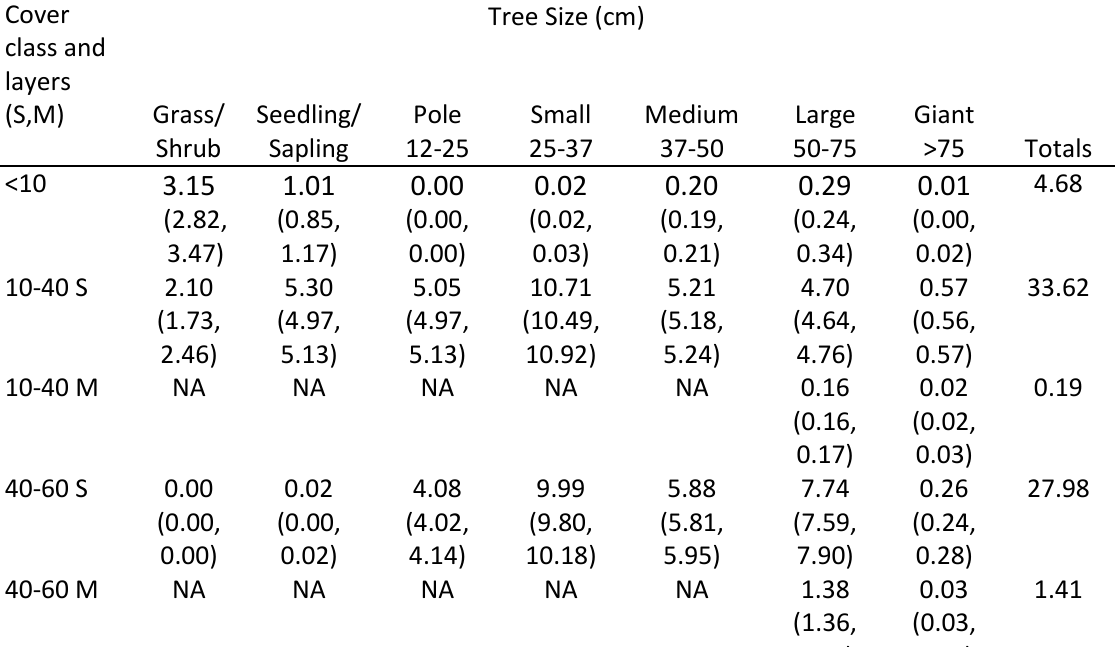
Table A1.2. Mean percent of study area in vegetation structure (cover, tree size and layers (single or multi)) used in state and transition models at year 50. Values in parentheses are lower and upper 95 th percentile confidence intervals from 15